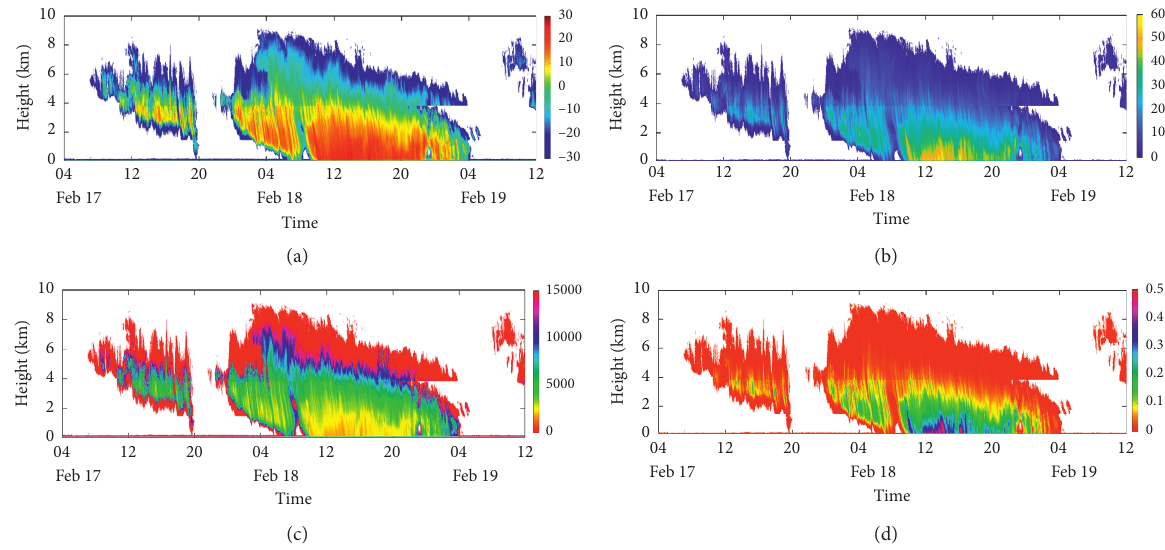
Figure 8: Time-height profile of millimeter-wave cloud radar data: (a) reflectivity factor (shaded; unit, dBz), (b) particle radius (shaded; unit, μ m), (c) unit volume number concentration (shaded; unit, per mm − 3 ), and (d) ice water content (shaded; unit, g m − 3